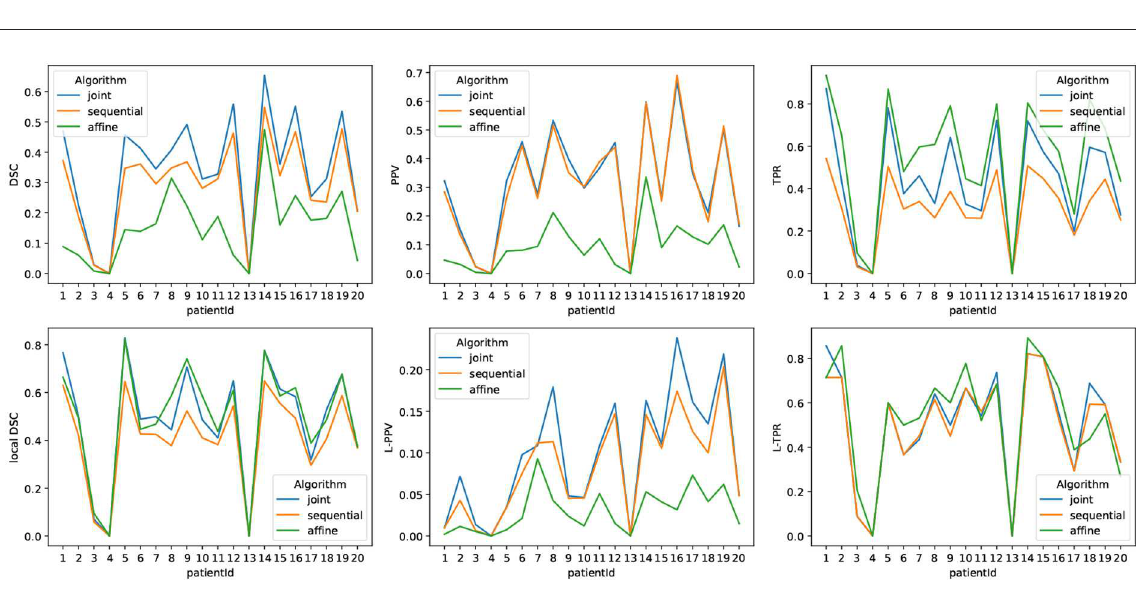
detections around the ventricles. However, the sequential method failed to detect the whole lesion areas due to the over- compensation of lesion changes. This limitation is overcome by the joint approach that succeeds to detect the entire lesion